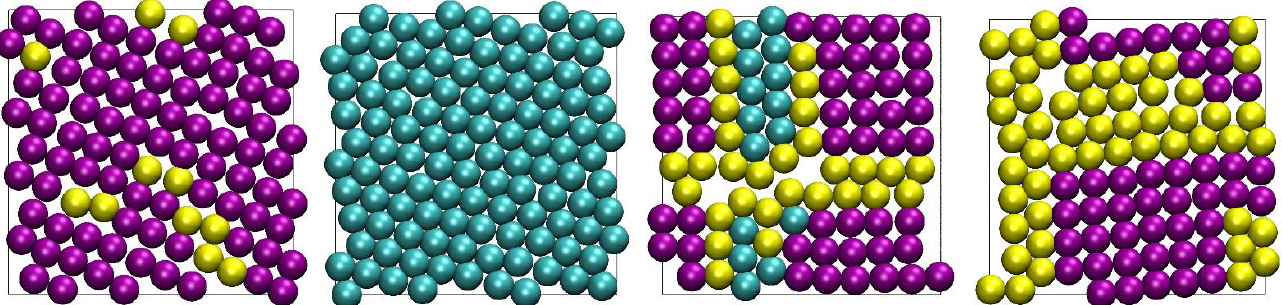
Figure 12. Projected surface morphologies at the end of the MC simulations, as identified by the 2-D CCE-norm analysis for the (from left to right ): N = 12, ϕ = 0.56 (top layer); N = 24, ϕ = 0.58 (bottom layer); N = 12, ϕ = 0.60 (top layer); and N = 12, ϕ = 0.61 (top layer) systems. The figure panels are also available as 3-D, interactive images.